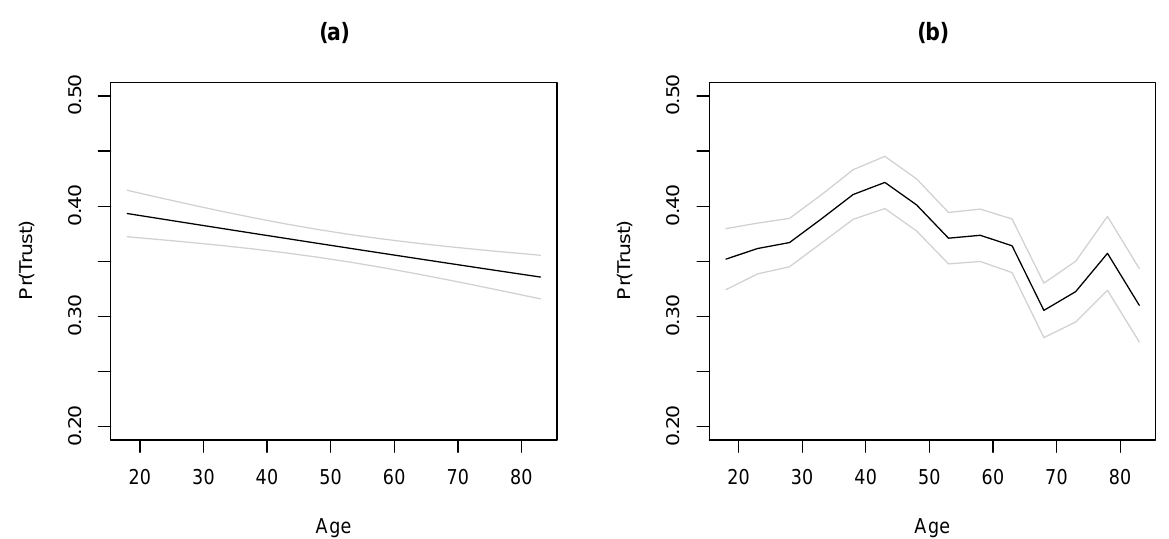
Figure 4: Diachronic age slope and curve. Notes: (a) displays the diachronic age slope, whereas (b) displays the diachronic age curve. Calculations are based on θ 1 ( i − i ∗ ) and θ 1 ( i − i ∗ ) + Parameter estimates are derived from a diachronic L-APC logistic regression model. Upper and lower bounds denote 95 percent confidence intervals. Outcome is social trust, coded so that 1 = “can trust” while 0 = “can’t be too careful” or “depends.” Results adjusted using sampling